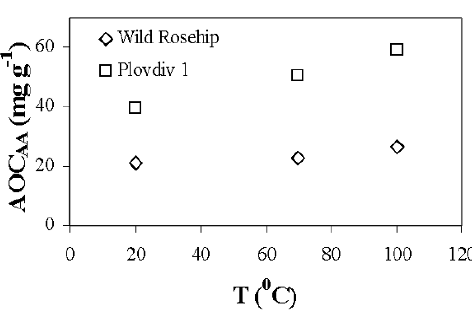
Figure 7. Antioxidant capacity of extracts obtained at different temperatures, 1 hour water extraction.